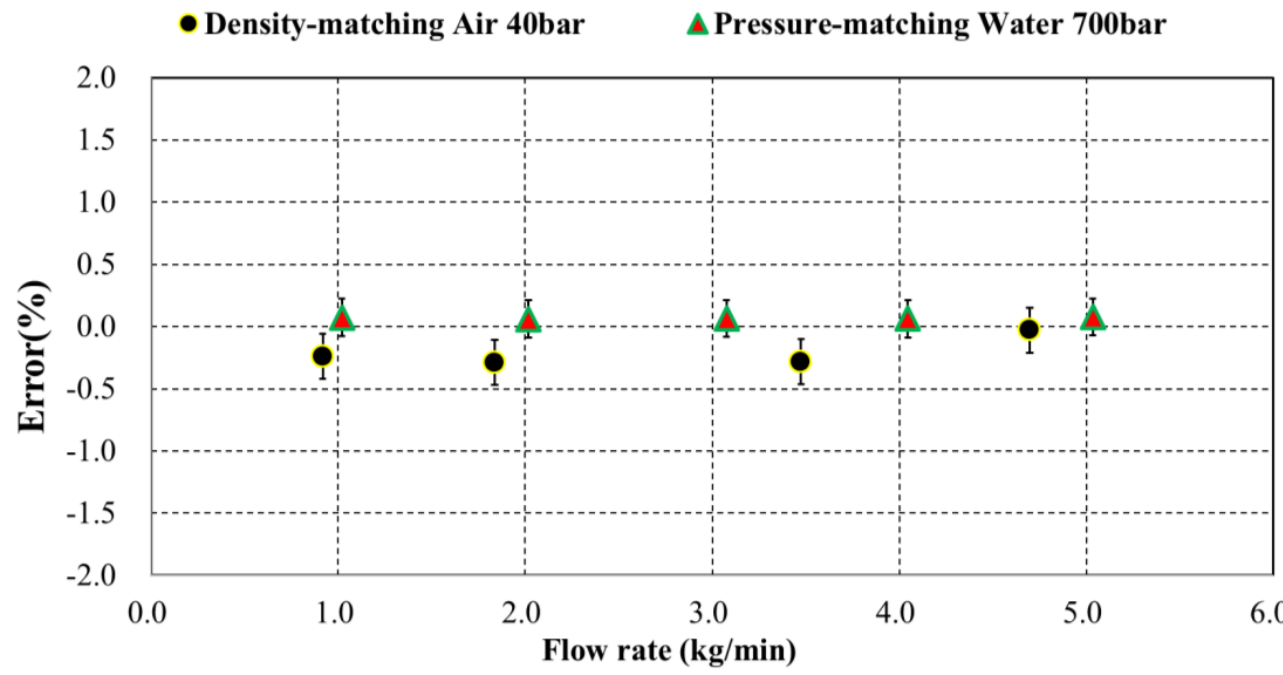
Figure 11. Comparison between the test results of Coriolis mass flowmeters for the density-matching approach and the pressure-matching approach.